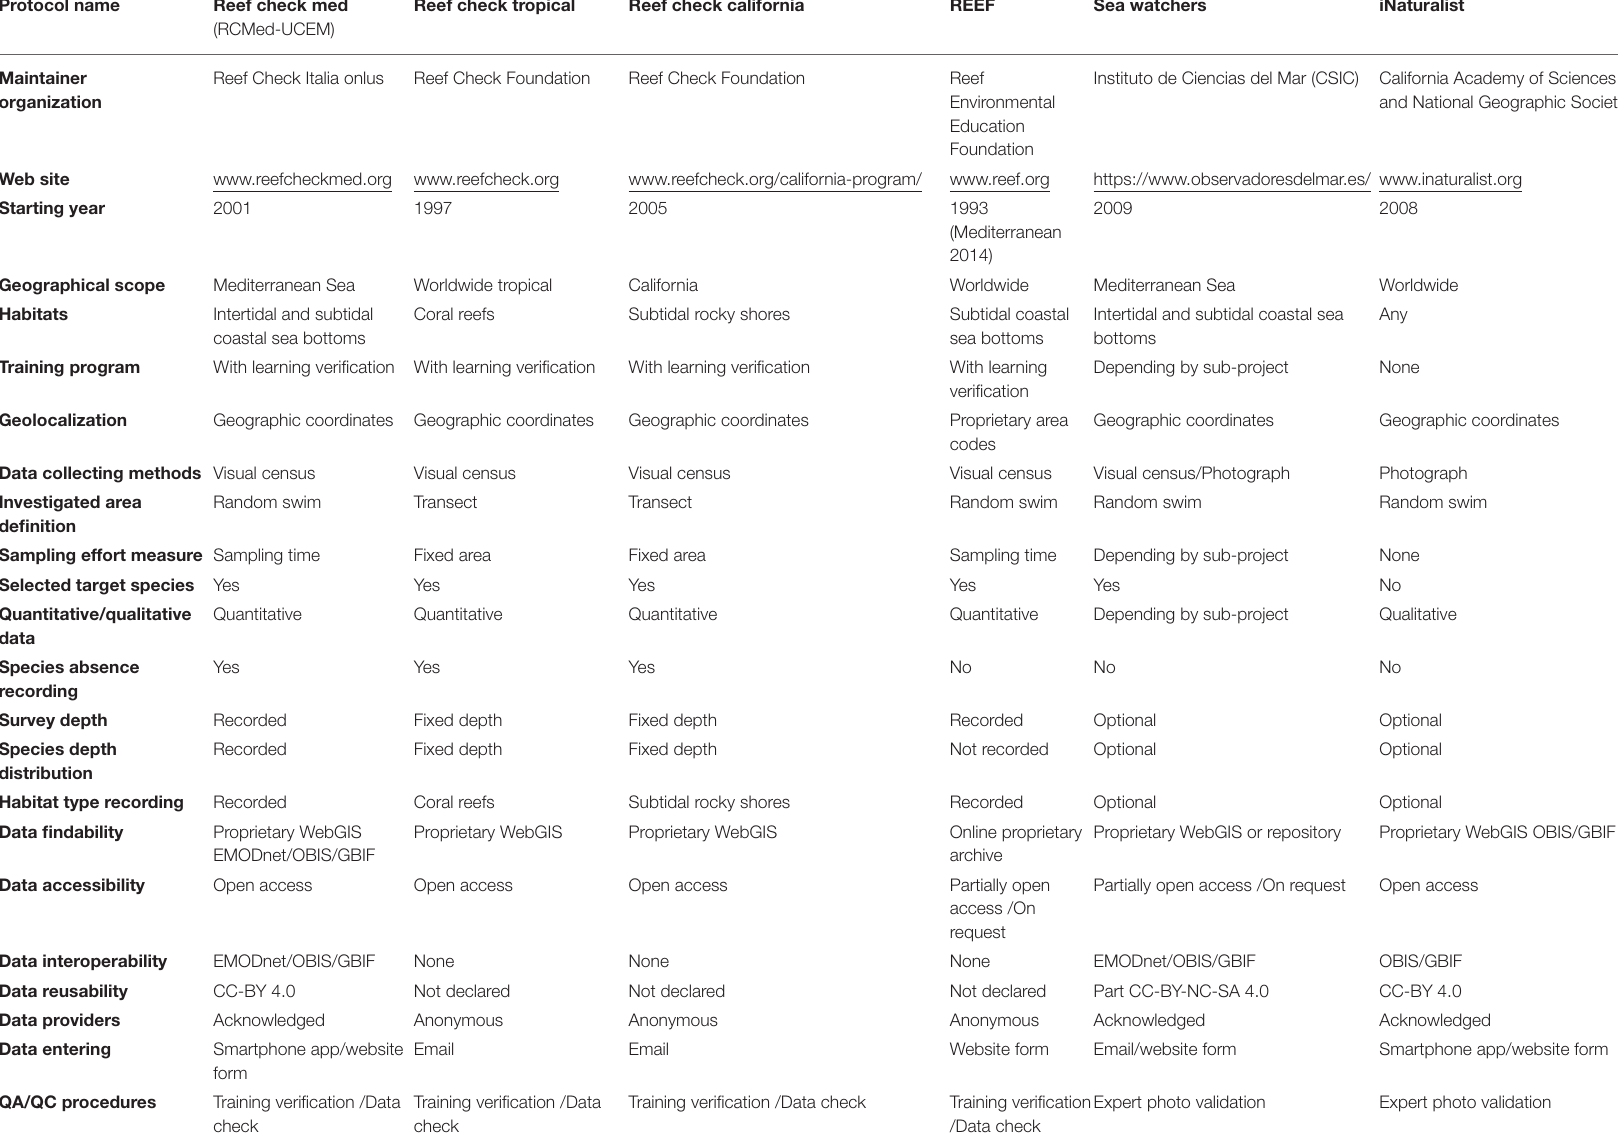
TABLE 5 | Selected protocols